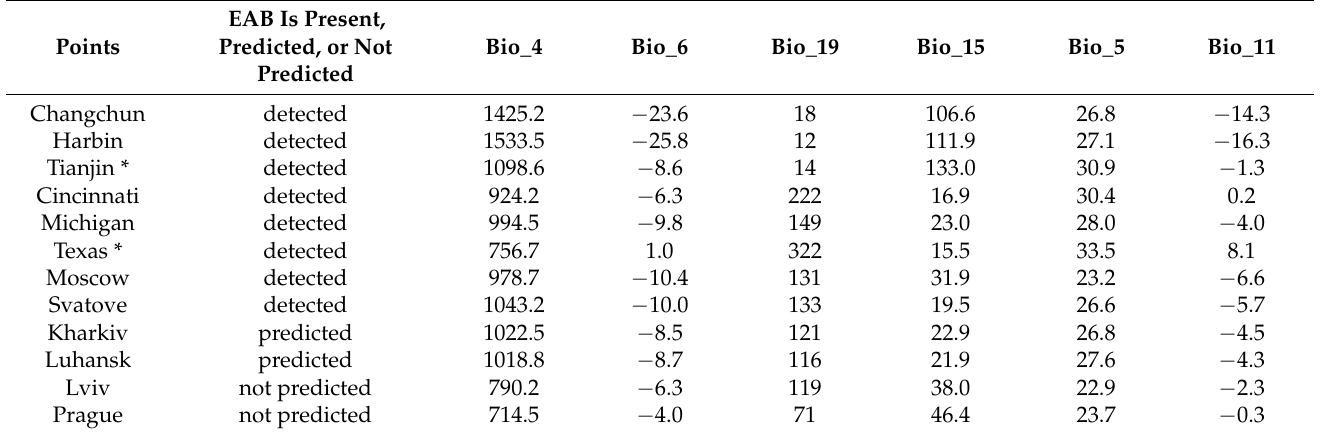
Table 7. Bioclimatic variables from MaxEnt for several points where EAB was detected, predicted, or not